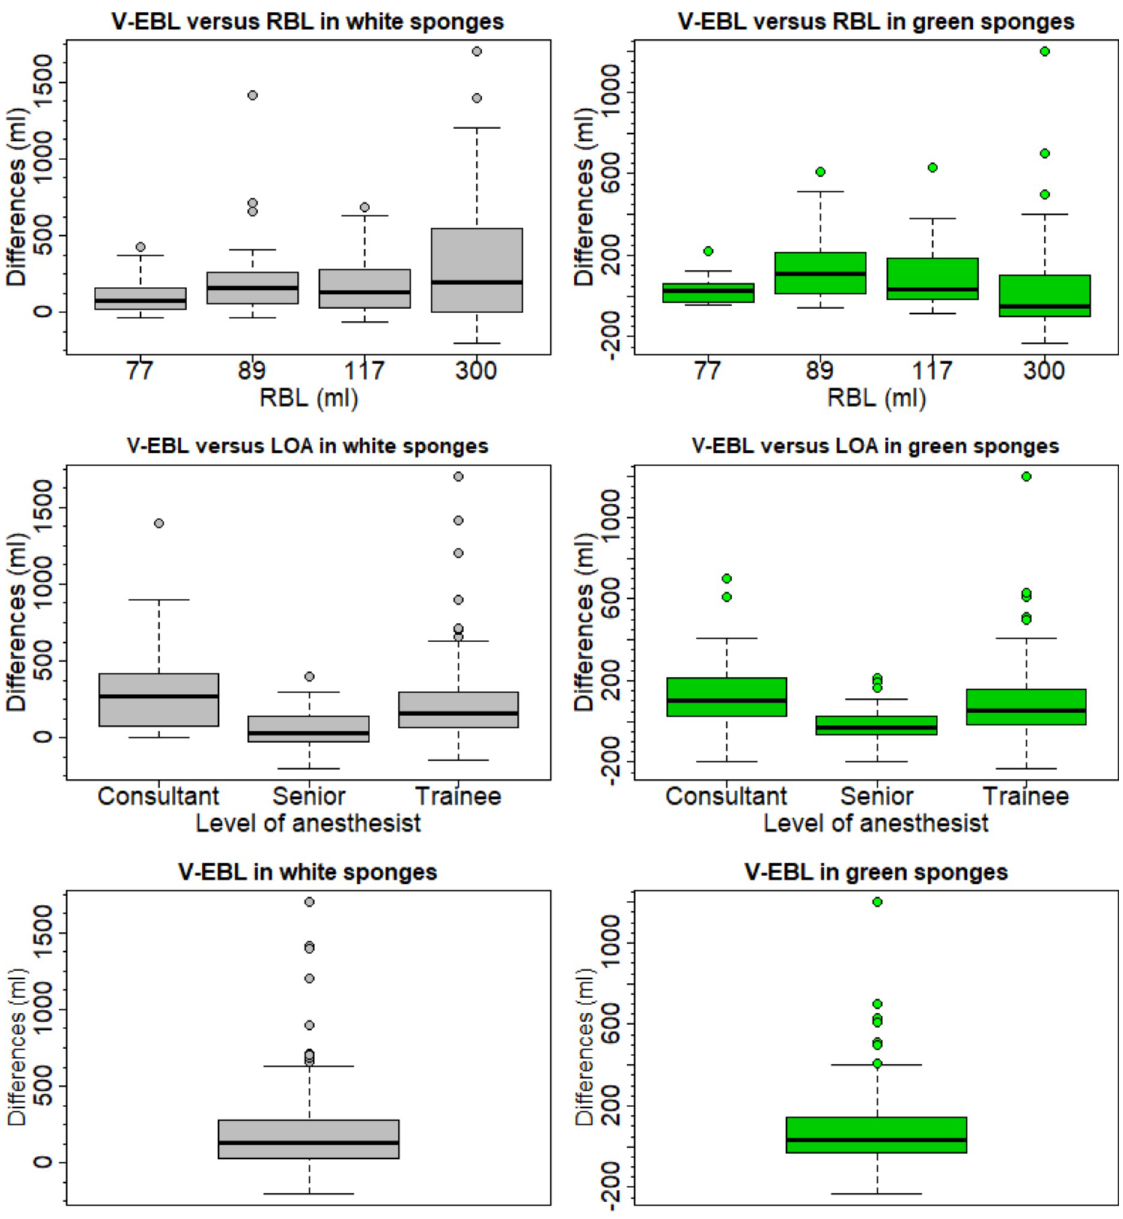
Fig 2. Boxplots for differences between visual blood loss estimation and reference blood loss in white and green sponges. Fig 2 demonstrates the differences between visually estimated blood loss (V-EBL) and reference blood loss (RBL) for white and green sponges per scenario, estimates by qualification level (LOA Level of anaesthetist) and total estimates by green and white sponges.